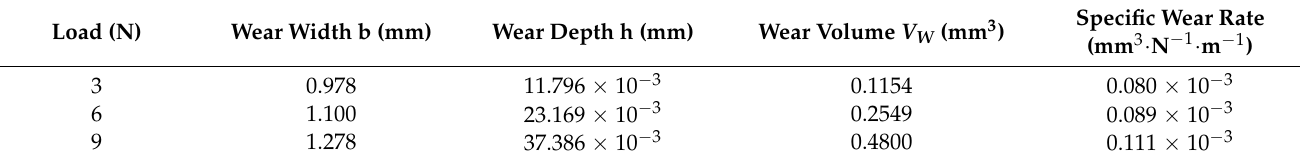
Table 3. The wear width, depth, volume, and specific wear rate of Ti-6Al-4V alloy under different load.